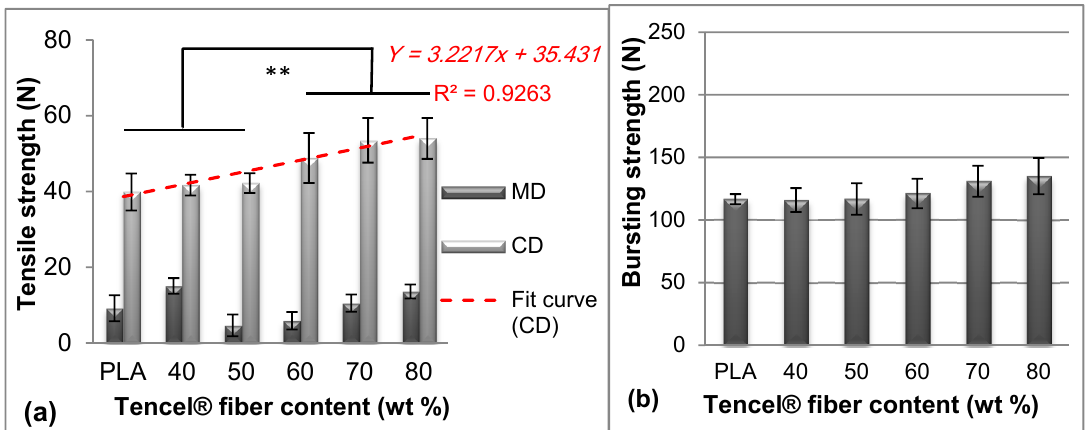
Figure 5. ( a ) Tensile strength and ( b ) burst strength of TCP nonwovens with various Tencel ® fiber contents, punching density of 100 punches/cm 2 , and areal weight of 100 g/m 2 . ** p < 0.01. Y = 3.2217 x + 35.431